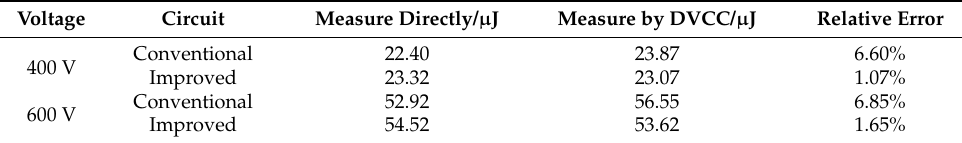
Table 6. Comparison of conduction loss measurement under different voltages.